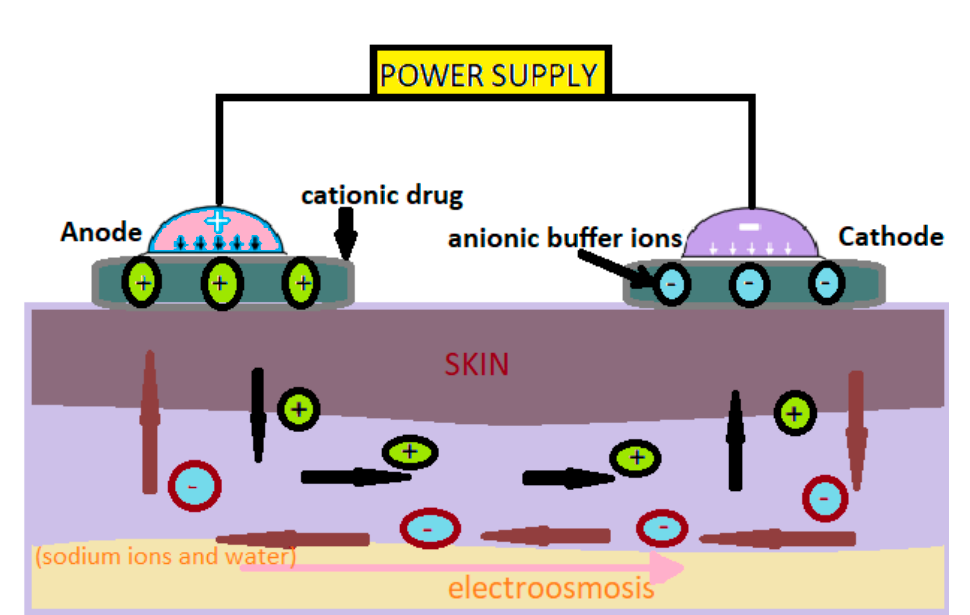
Figure 2. Administration of cationic drugs via iontophoresis. Mechanism [30].